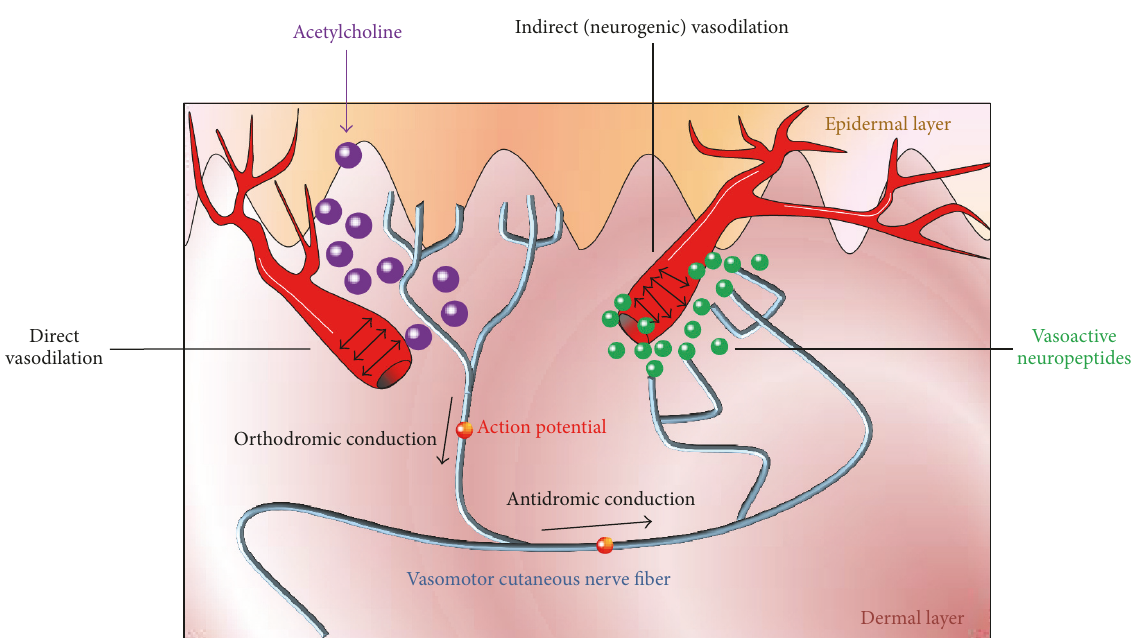
Figure 2: Illustration of the vasomotor axon reflex. Iontophoresis of acetylcholine induces vasodilation in the “direct” skin region of application via receptor activation. Consequently, an action potential emerges in the afferent nerve innervating this vessel. This potential travels in an orthodromic fashion to an axonal branch point where it switches to another vasomotor fiber. Upon antidromic conduction, the action potential reaches terminal nerve endings adjacent to a neighboring population of blood vessels. From these terminals, vasoactive substances are released to cause “indirect” vasodilation in a skin region which is surrounding the region of iontophoresis. Consecutive enhancement of blood flow relates to functional integrity of the stimulated vasomotor nerve fiber. Similarly, the axon reflex can be evoked in sympathetic adrenergic pilomotor and sympathetic cholinergic sudomotor fibers. Figure designed by Dr. Siepmann and Dr.